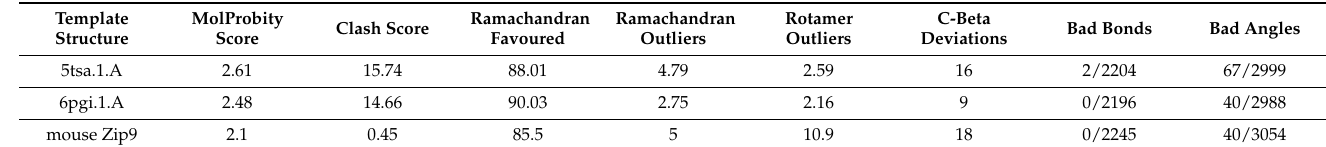
Table 1. Comparative analysis of three models generated using SWISS